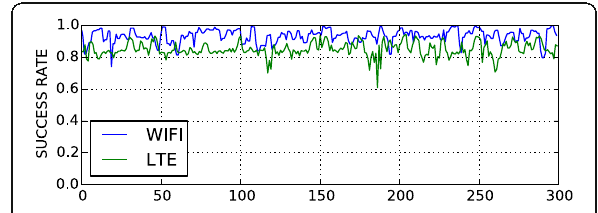
Fig. 9 LTE-U (6 ms activity, 4 ms of silence) + WiFi Legacy DCF Fig. 10 LTE-U (6 ms activity, 4 ms of silence) + WiFI WMP